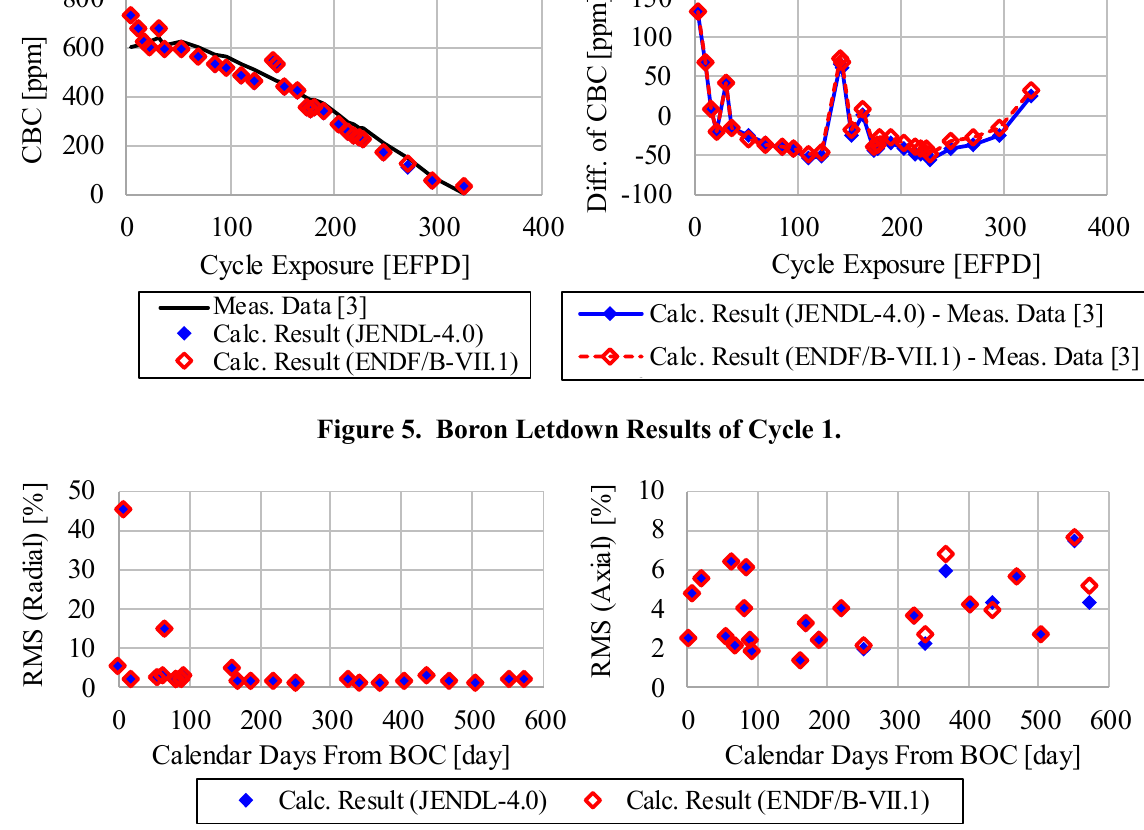
Calc. Result Figure 6. Detector Signal Results of Cycle 1 (Left: Radial, Right: Axial).